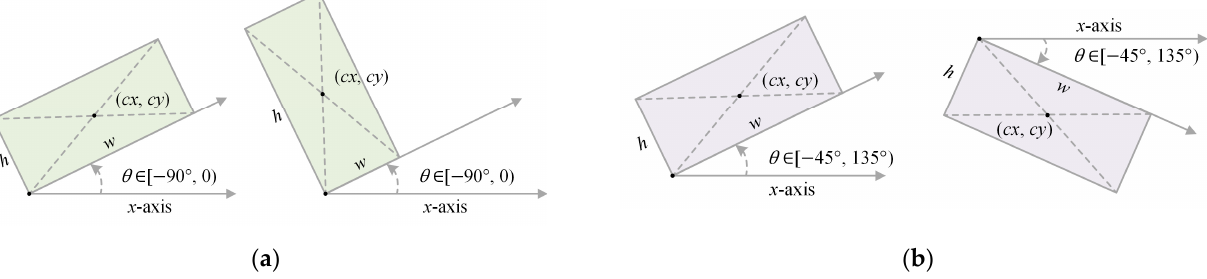
Figure 3. Two generic parametric definitions of oriented bounding boxes. ( a ) OpenCV definition, where θ indicates the acute or right angle between the width w and the x -axis; ( b ) Long-edge definition, where w and h signify the long side and short side of a bounding box, respectively. Here, θ denotes the angle from the x -axis to the direction of the width w .